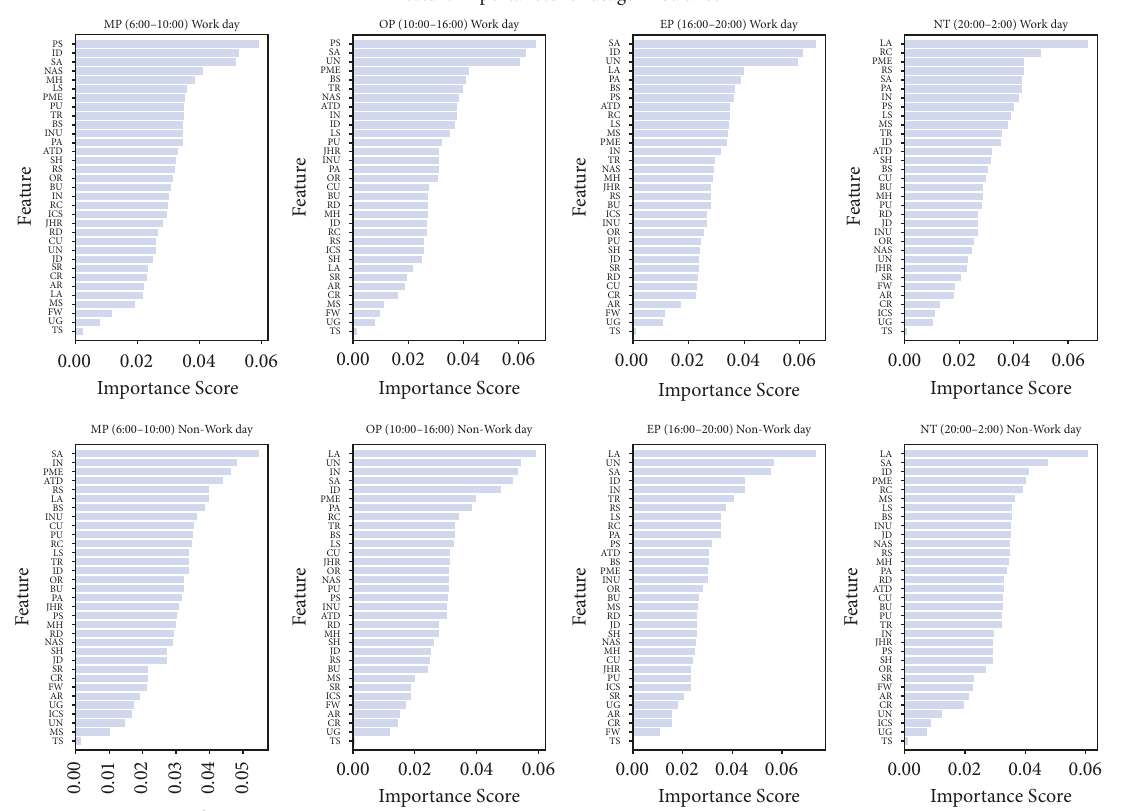
Figure 5: Feature importance for usage